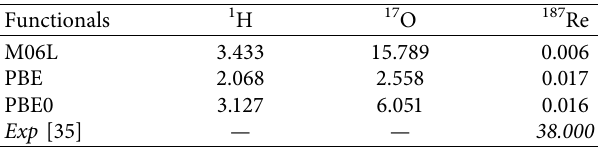
Table 4: Hyperfne coupling constants, A diferent functionals, in solution, and without relativistic efect.